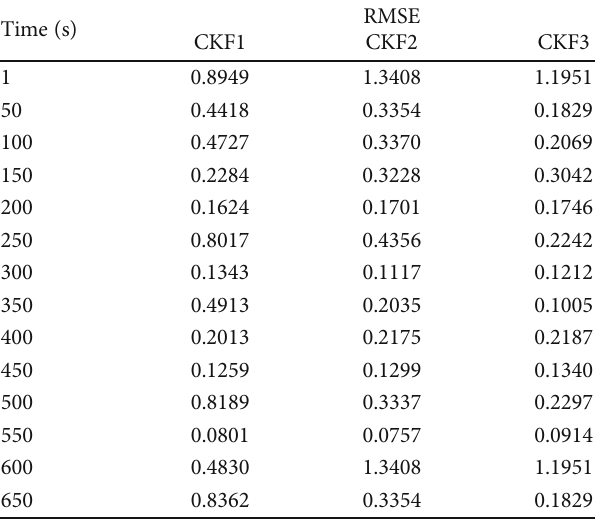
Table 4: Error comparison results of improved